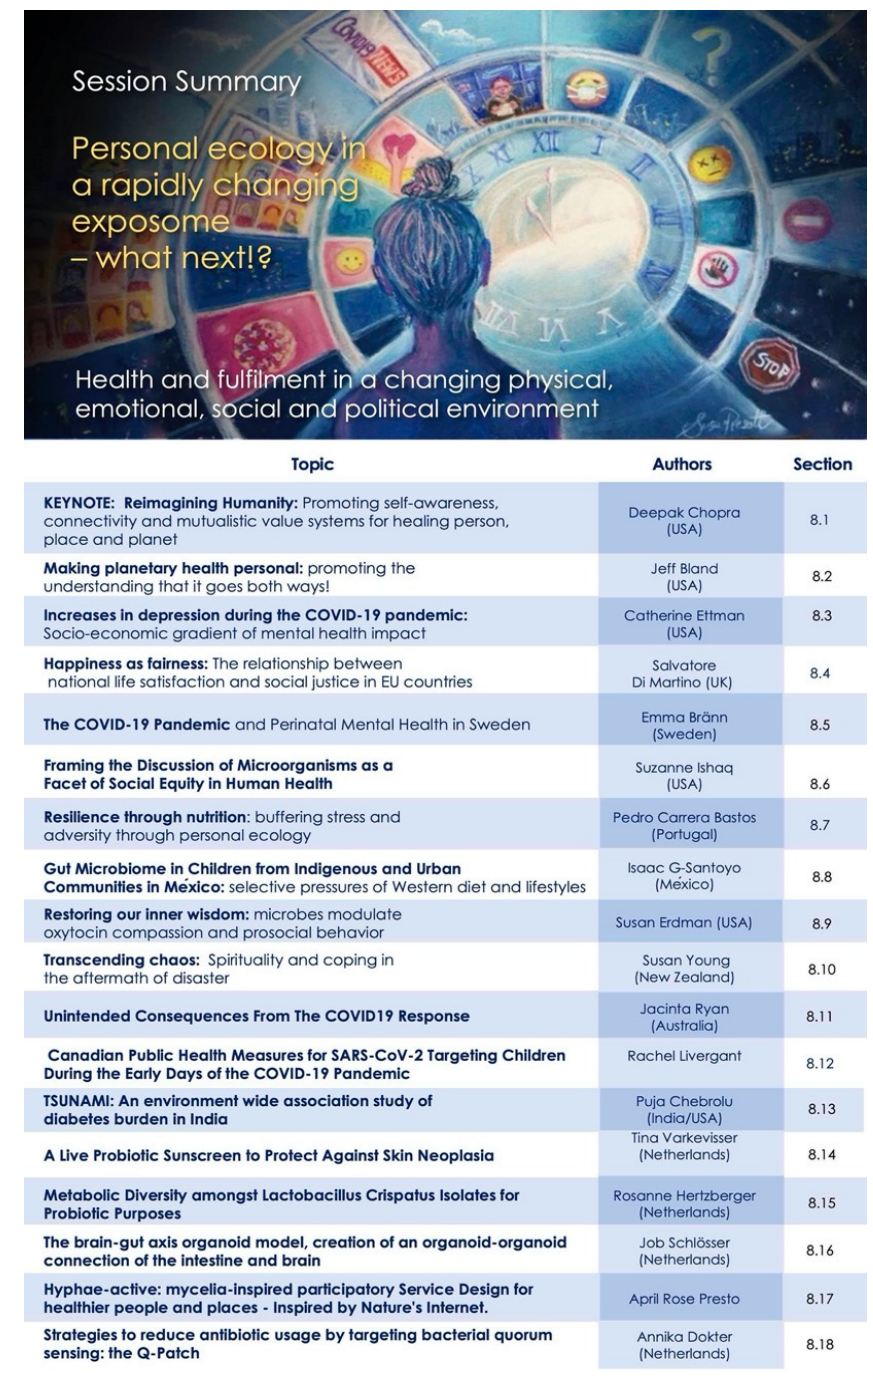
Figure 7. Health and fulfilment in a changing physical, emotional, social and political environment. Overview of topics and speakers in the session on personal ecology in a rapidly changing exposome.